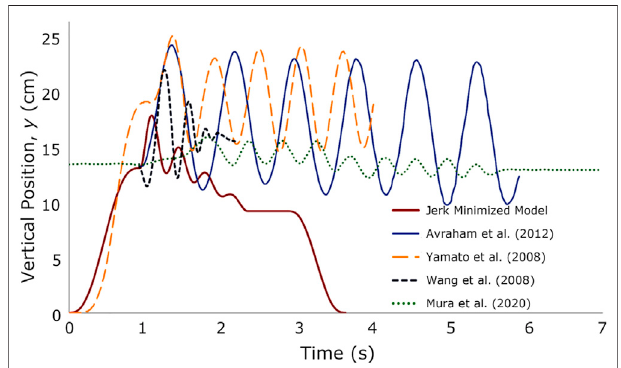
FIGURE 5 | Vertical hand movement comparisons of human-to-human handshake against human-robot handshake [data extracted from Avraham et al. (2012); Yamato et al. (2008); Wang et al. (2008); Mura et al.